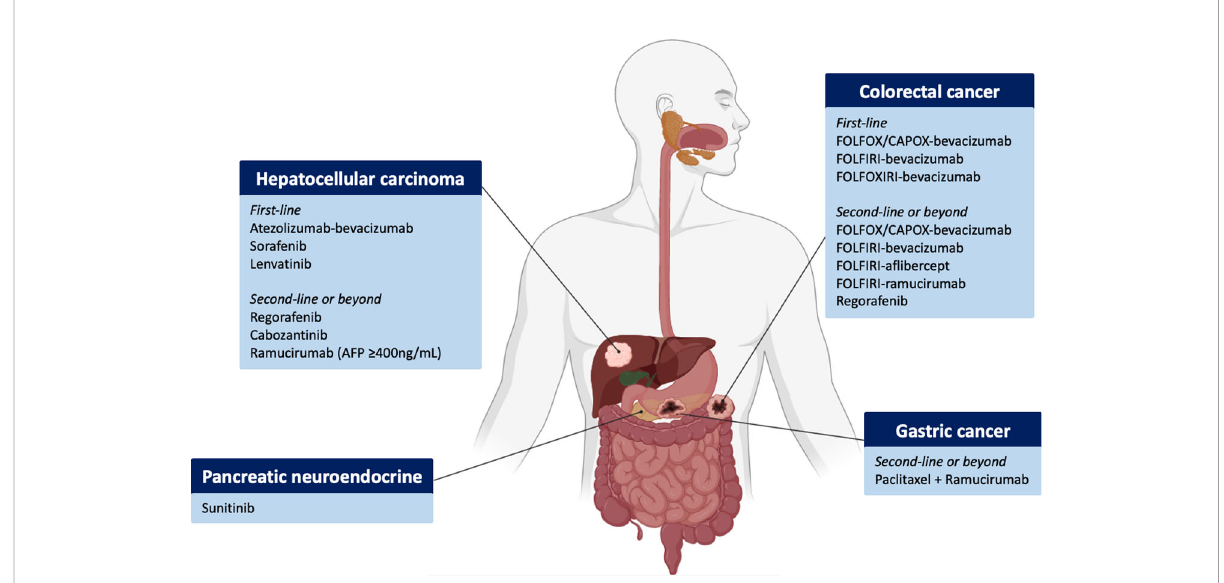
FIGURE 1 Overview of FDA-approved antiangiogenic agents across gastrointestinal and hepatobiliary tumours and disease settings. Figure generated with